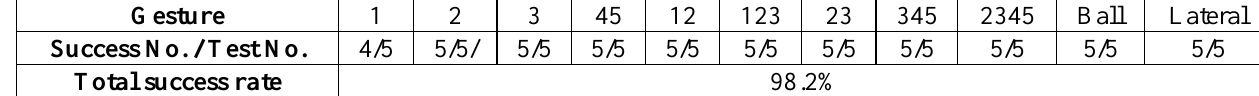
Table 2. Success rate of the 11-gesture classification of the first subject. Gesture Success No. / Test No.